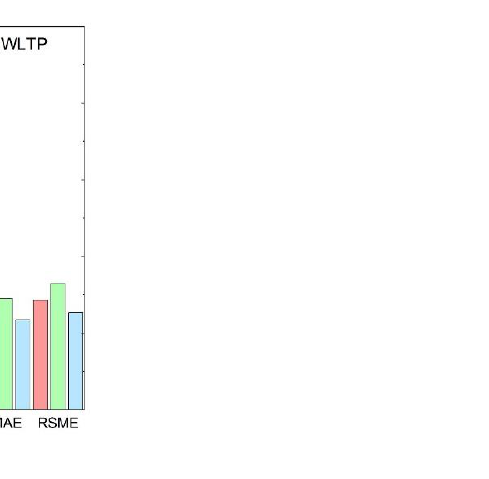
Figure 14. The mean absolute error (MAE) and root mean square error (RMSE) obtained from the three parameter estimators.